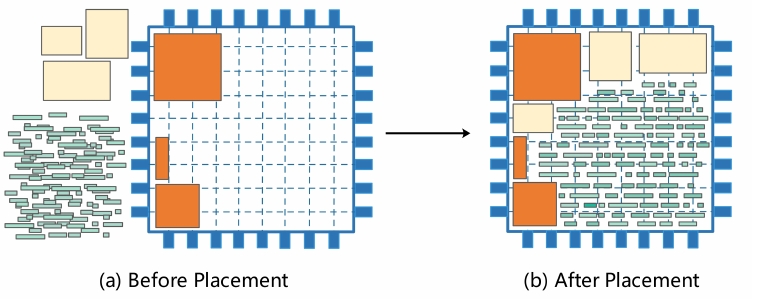
Figure 4. Description of the placement process. The placement region is usually rectangular and can be divided into several bins. The blue rectangles form the placement region. The orange, milk- white, and green rectangles represent fixed-position macros, movable macros, and movable standard cells,